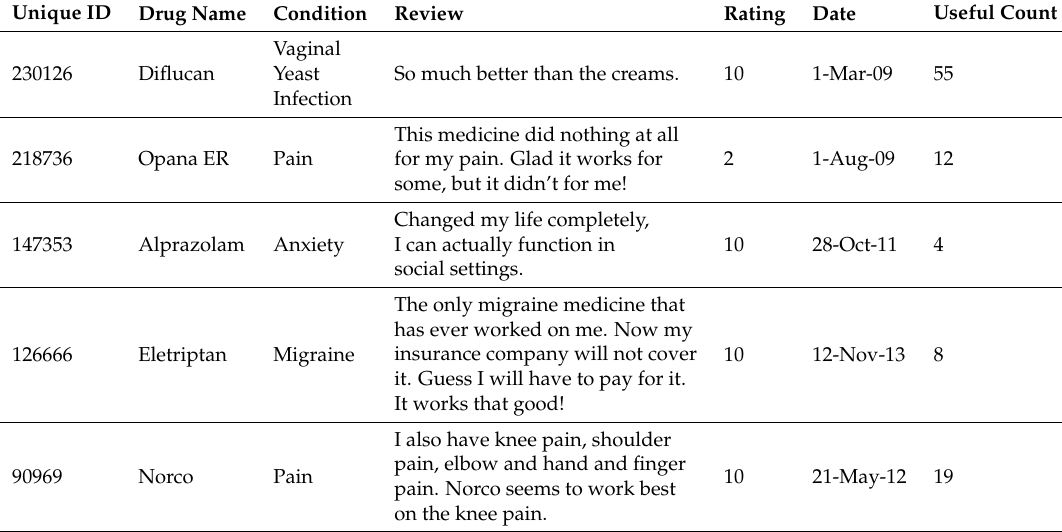
Table 1. Sample of drug review data-set used in our